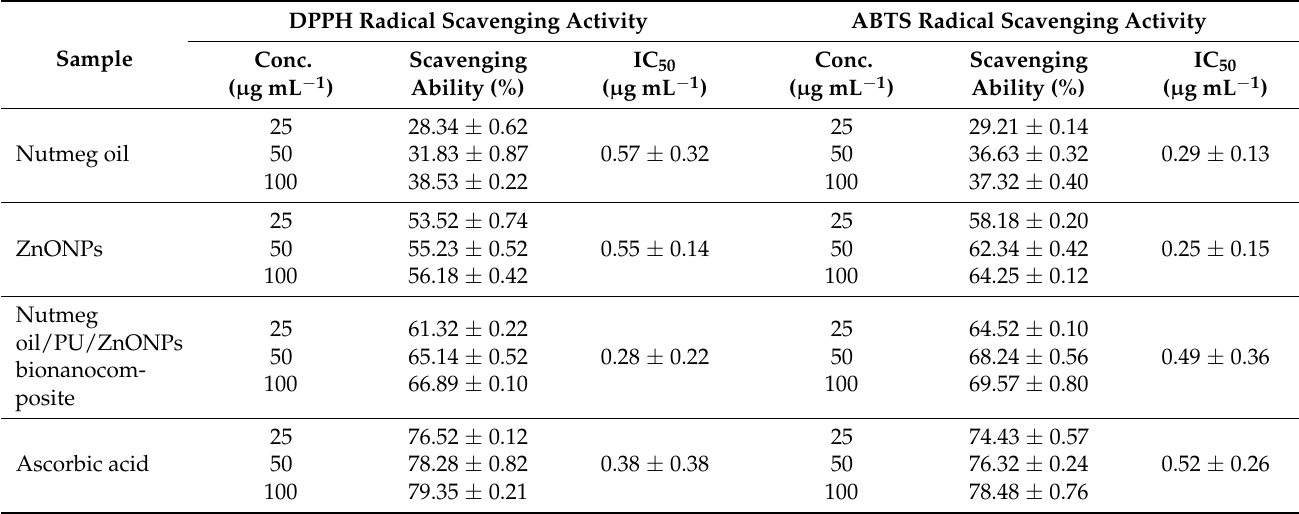
Table 3. DPPH and ABTS scavenging activity of nutmeg oil, ZnONPs, and nutmeg oil/PU/ZnONPs bionanocomposite. DPPH Radical Scavenging Sample